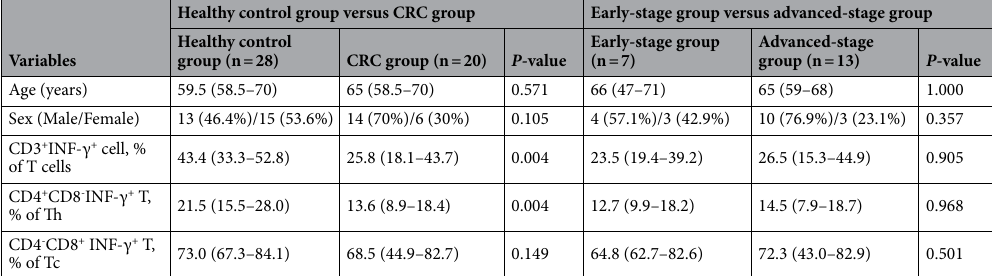
Table 2. The INF-γ secretion function of lymphocytes in healthy control group versus CRC group as well as early-stage group versus advanced-stage group. CRC, Colorectal cancer; INF-γ,